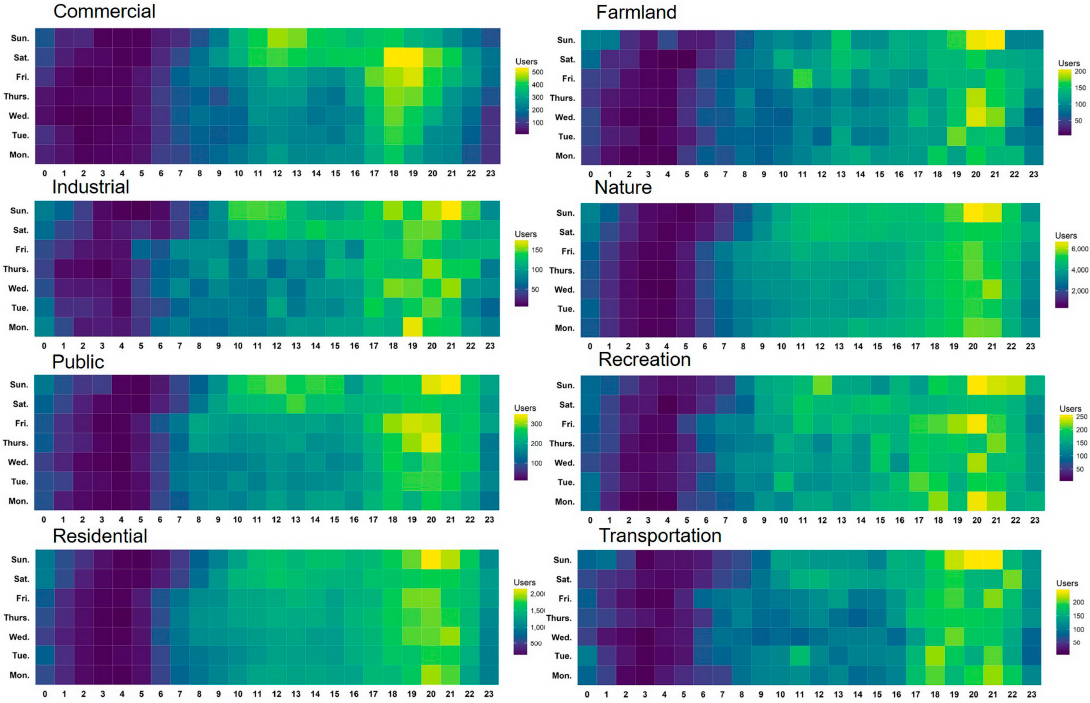
Figure 8. Temporal frequency of active users by land use categories.